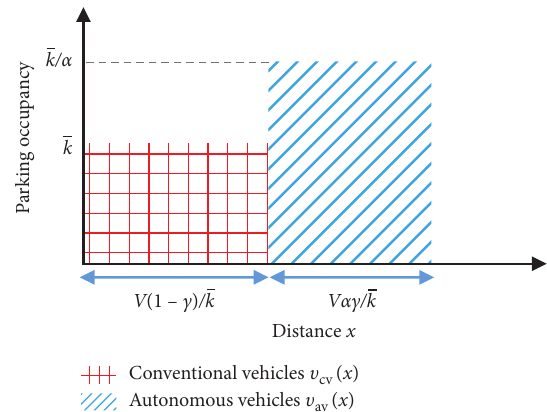
Figure 3: Parking occupancy of CVs and